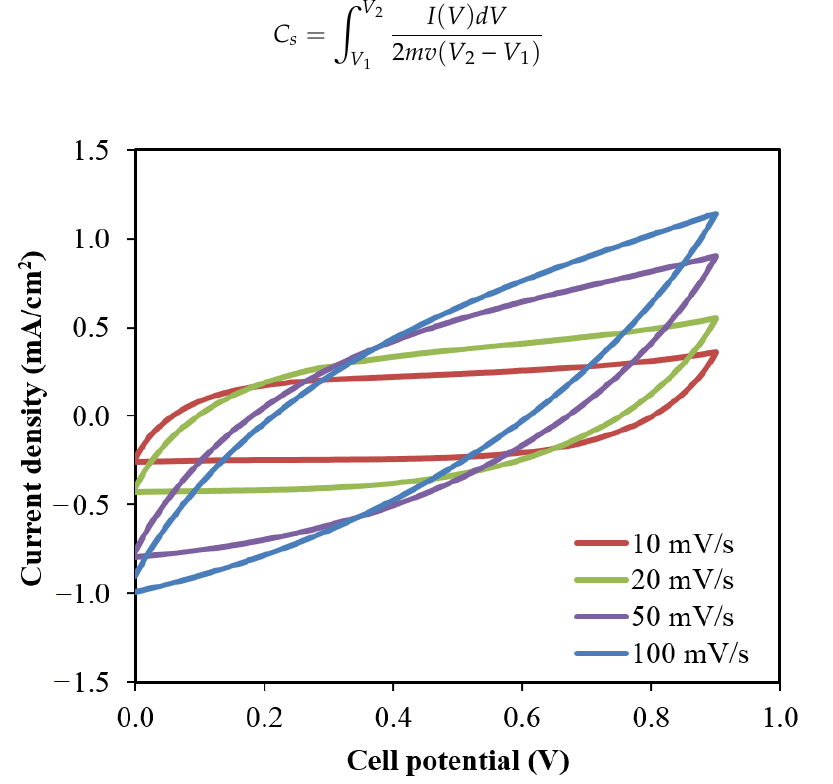
Figure 9. The plot of CV curves at different scan rates.